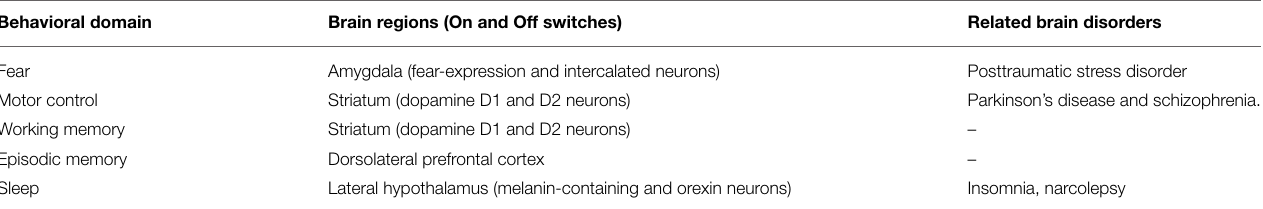
TABLE 1 | On and off neurons and associated brain disorders. Behavioral